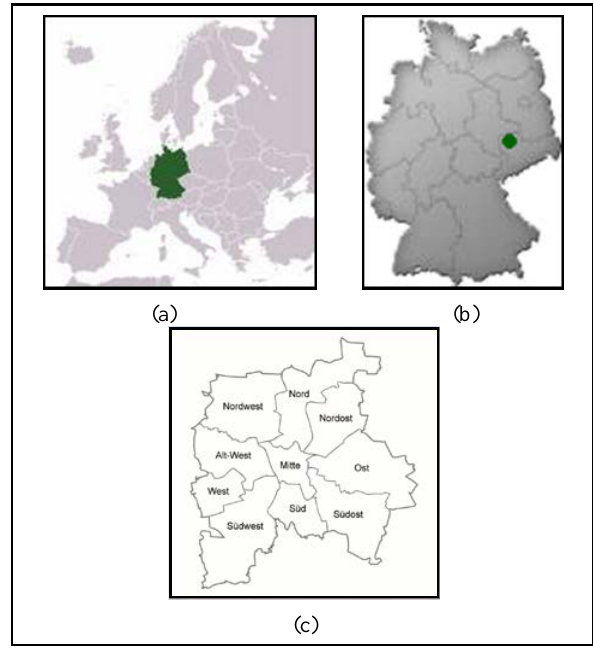
Figure 1. Location of case study, (a) in Europe, (b) in Germany, (c) City of Leipzig with its 10 urban